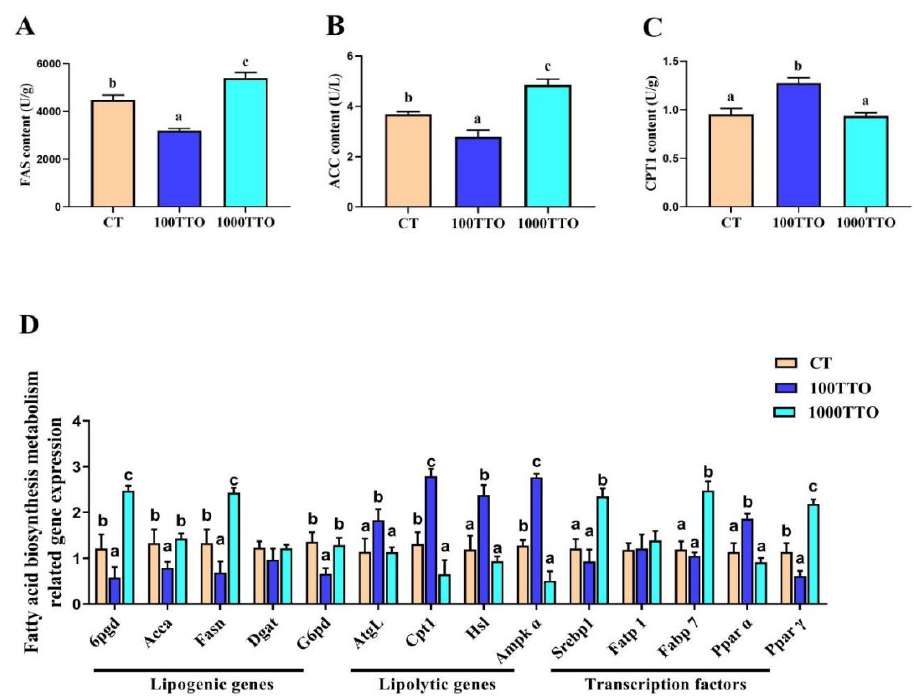
Figure 4. Effects of dietary TTO levels on hepatopancreatic lipid metabolism of M. rosenbergii. ( A ) FAS content; ( B ) ACC content; ( C ) CPT1 content. ( D ) mRNA expression of lipid metabolism ‐ related genes. The significant difference between the three TTO levels is characterized by different lower ‐ case letters (a, b, c) ( p < 0.05).